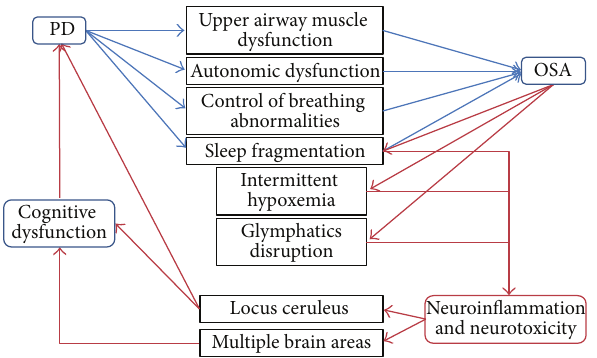
Figure 1: Hypothetical mechanistic relationship between PD and OSA.Legend.PD:Parkinson’sdisease;OSA:obstructivesleepapnea.